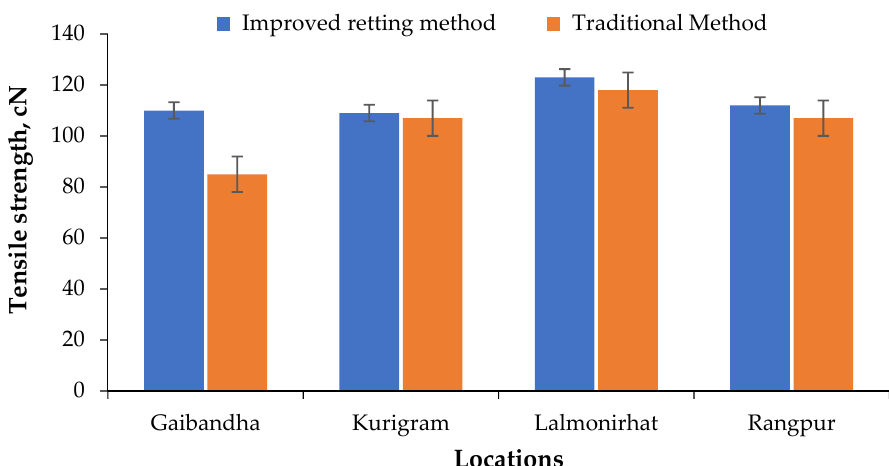
Figure 18. Tensile strength (cN) of jute fiber as influenced by different retting methods in four locations in Bangladesh. Vertical bars indicate the standard errors of the mean.